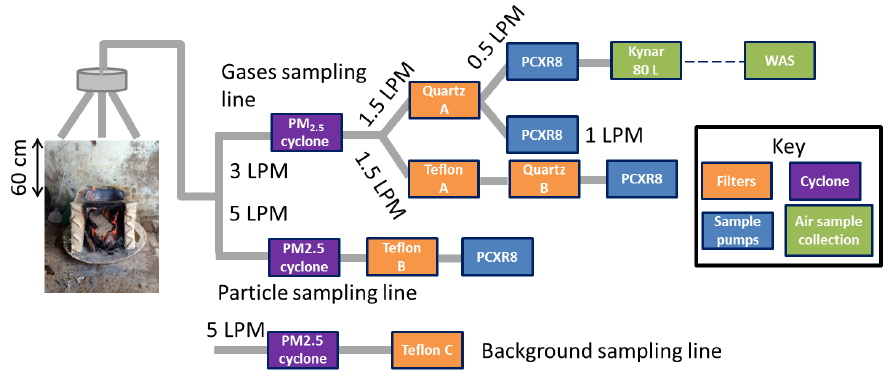
Figure 1. Sampling train for collecting cookstove emissions. PCXR8 (blue) are sampling pumps, WAS or whole-air samples (green) are the air samplers, and orange boxes are Teflon or quartz filters used to collect PM 2 . 5